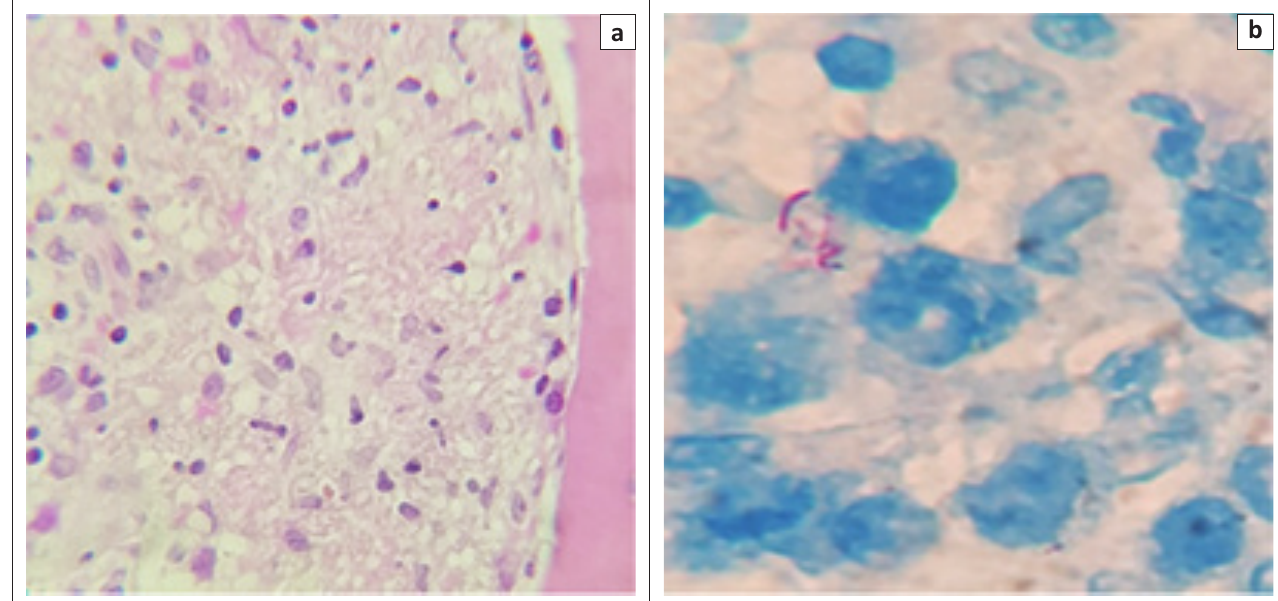
FIGURE 3: Bone marrow trephine biopsy showing acid-fast bacilli. (a) An area of granulomatous inflammation (haematoxylin and eosin, 200× magnification). (b) A Ziehl- Neelson stain was positive for scanty acid-fast bacilli (black arrow, 1000×